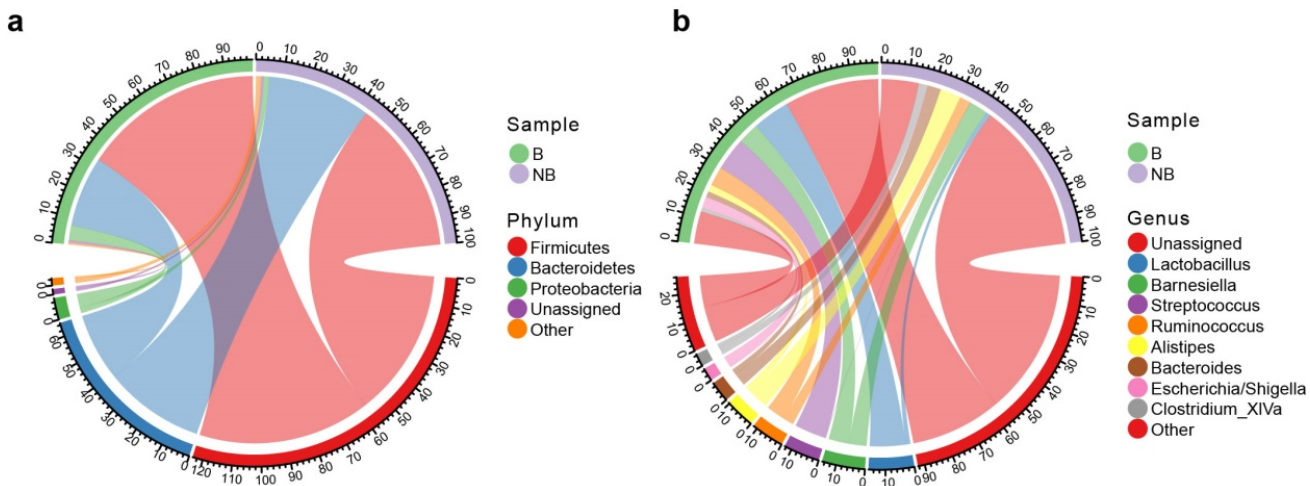
Figure 2. Taxonomic analysis of the gut microbial community composition of each group. Sequences that could not be assigned at the phylum level ( a ) and genus level ( b ) were marked as “Unassigned”. B, breeding season; NB, non-breeding season. ( a ) Chord diagram at the phylum level. ( b ) Chord diagram at the genus level.